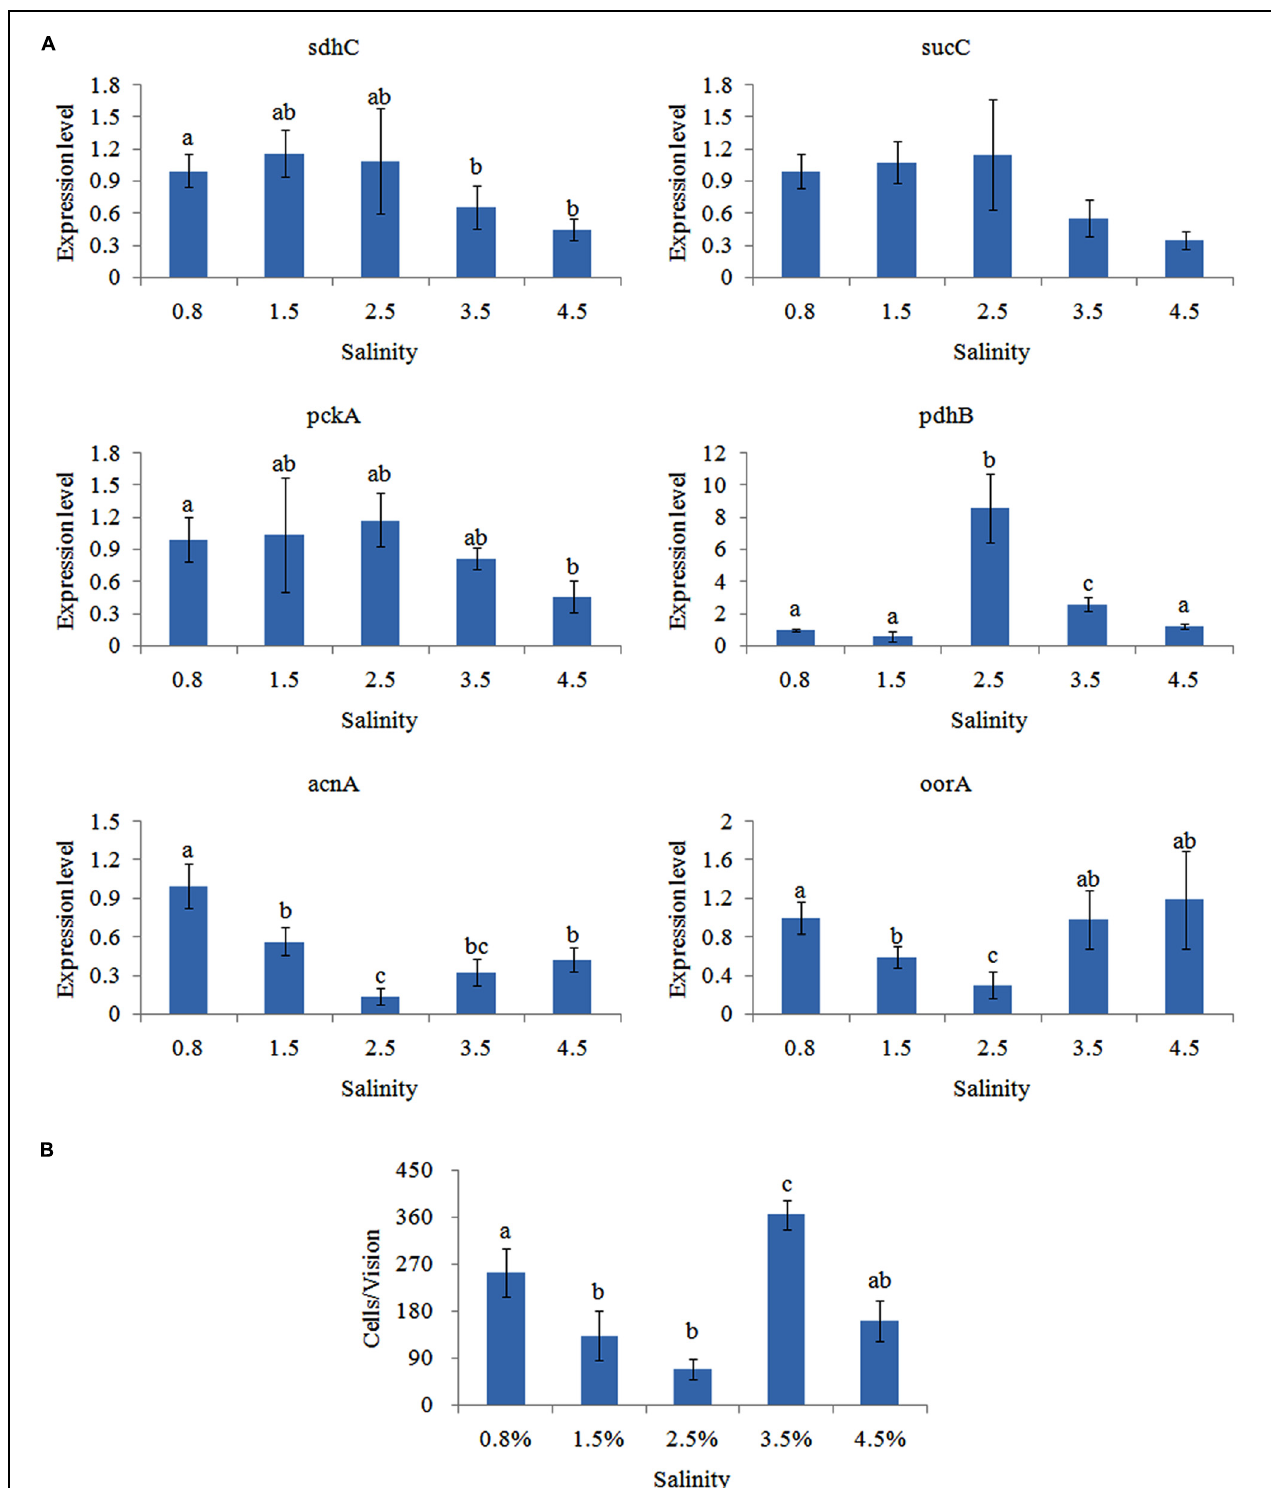
FIGURE 5 | Salinity affected the adhesion of V. alginolyticus . (A) qPCR analysis of the expression of sdhC , sucC , pckA , pdhB , acnA , and oorA after treated with different salinities. The data are presented as the means ± SD, n = 6. The means of the treatments not sharing a common letter are significantly different at P < 0.05. (B) The adhesion capacity to mucus of V. alginolyticus cultured under different salinities. The data are presented as the means ± SD, n = 3. The means of the treatments not sharing a common letter are significantly different at P < 0.05, as assessed using one-way ANOVA followed by Dunnett’s test.